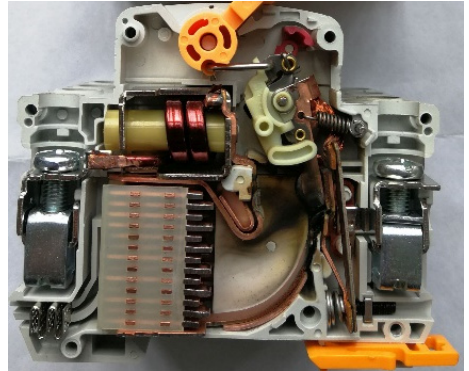
Figure 3. Experimental prototype.